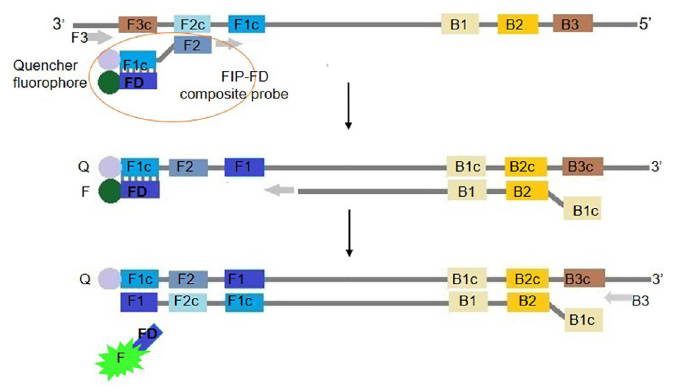
Fig 1. Schematic presentation of the mechanism of mLAMP.